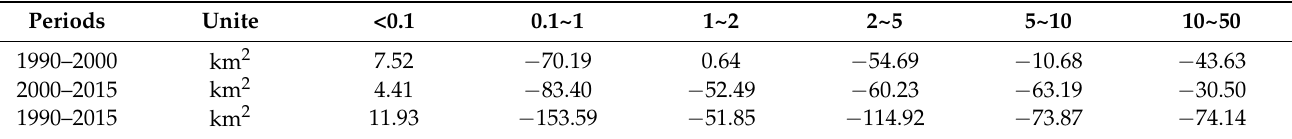
1990 to 1990 to 2015.